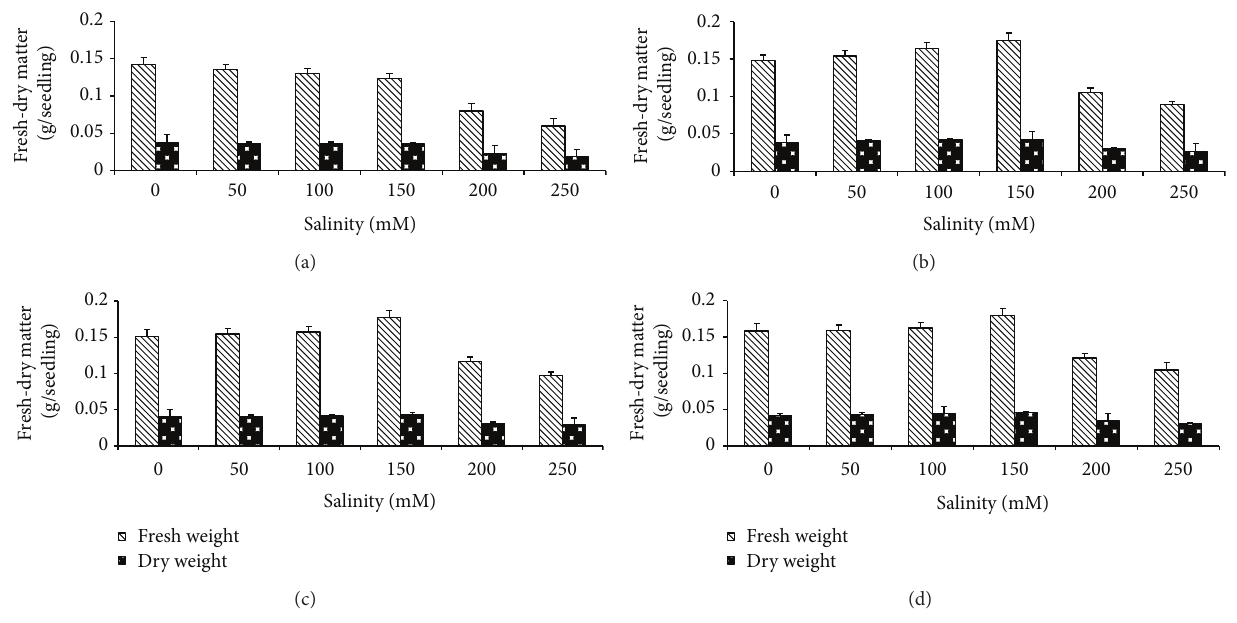
Figure 3: Effect of NaCl on fresh-dry matter of T. aestivum grains presoaked in different concentrations of Ulva lactuca : (a) control, (b) algal extract 1%, (c) algal extract 5%, and (d) algal extract 10%. Data are the mean of three replicates and error bars represent the standard errors of the means.